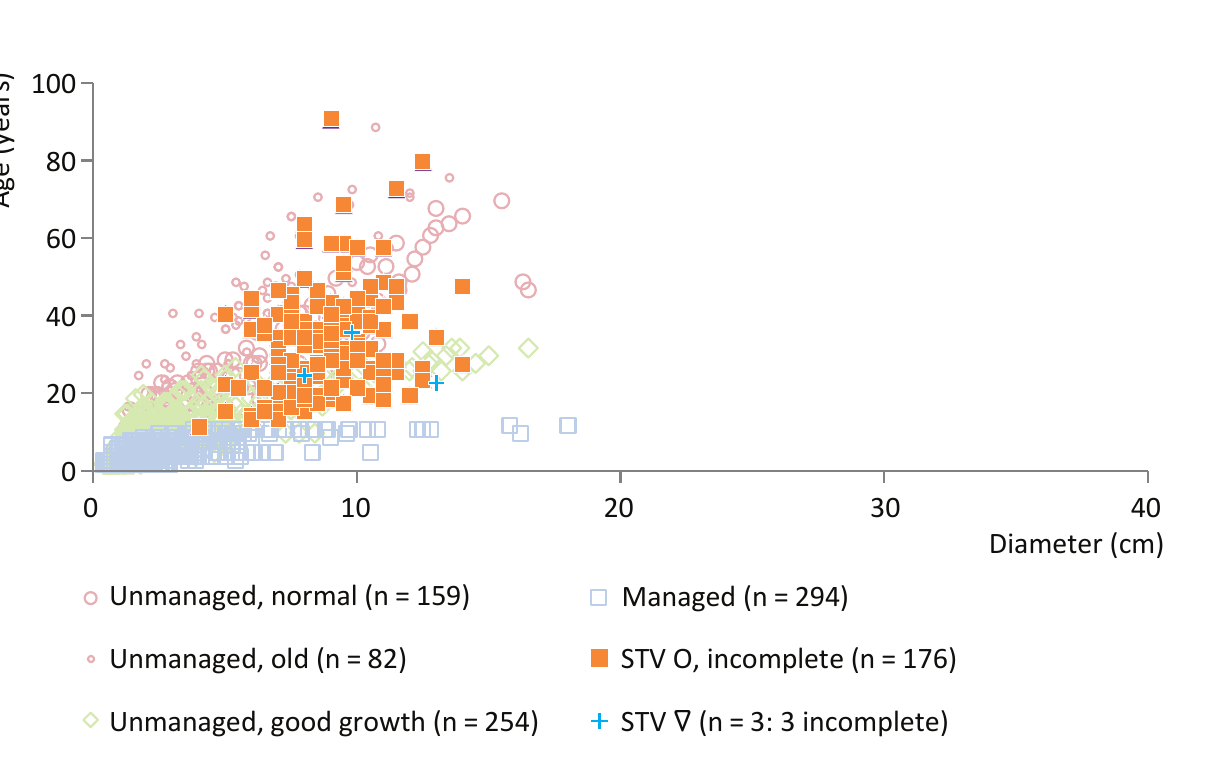
Figure 7. Ash posts from Strojanova voda, cluster IG, plotted against a representative selection of modern ash reference data. O = roundwood, ∇ = split